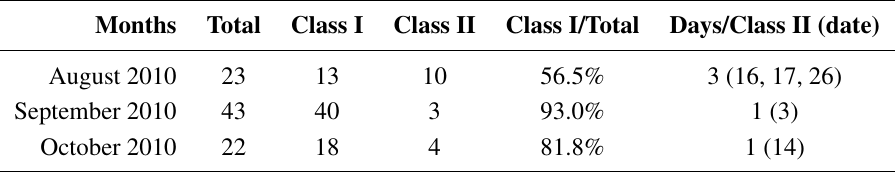
Table 3. Statistics of the performed measurements of LiDAR